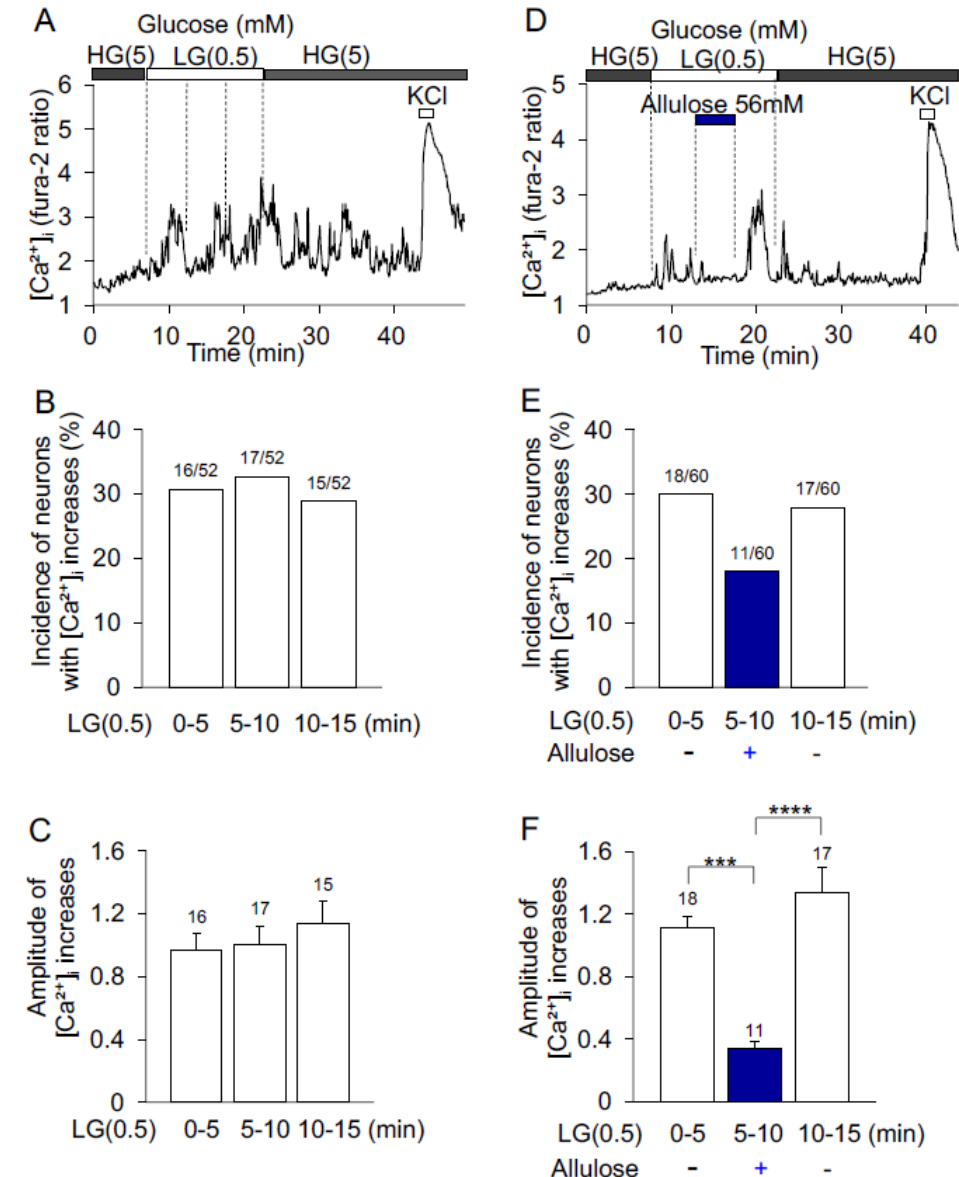
Figure 2. Effects of D -allulose on low glucose-induced [Ca 2 ⁺ ] i increases in ARC neurons. Single neurons were superfused with HKRB containing 5 mM glucose. ( A ) The superfusate HKRB containing high glucose (HG, 5 mM) was shifted to that containing low glucose (LG, 0.5 mM) for 15 min. [Ca 2 ⁺ ] i started to increase during the first 0–5 min and continued to be increased during the middle 5–10 min and last 10–15 min periods of 15 min LG exposure. This neuron subsequently responded to KCl with an increase in [Ca 2 ⁺ ] i. ( B ) Incidence of ARC neurons with [Ca 2 ⁺ ] i increases during the first, middle and last periods of 15 min LG exposure. The numbers above each bar indicate the number of neurons that showed [Ca 2 ⁺ ] i increases in response to LG over that examined. ( C ) Amplitude of LG-induced [Ca 2 ⁺ ] i increases during the first, middle and last periods of 15 min LG exposure. Data are presented as mean ± SEM. No difference between groups by one-way ANOVA followed by Tukey’s test. ( D ) D -allulose was administered in the middle period of 15 min LG exposure. LG-induced [Ca 2 ⁺ ] i increase was inhibited by D -allulose administration in the middle period, and restored after washing D -allulose in the last period. This neuron subsequently responded to KCl with an increase in [Ca 2 ⁺ ] i. ( E ) Incidence of the neurons with [Ca 2 ⁺ ] i increases in